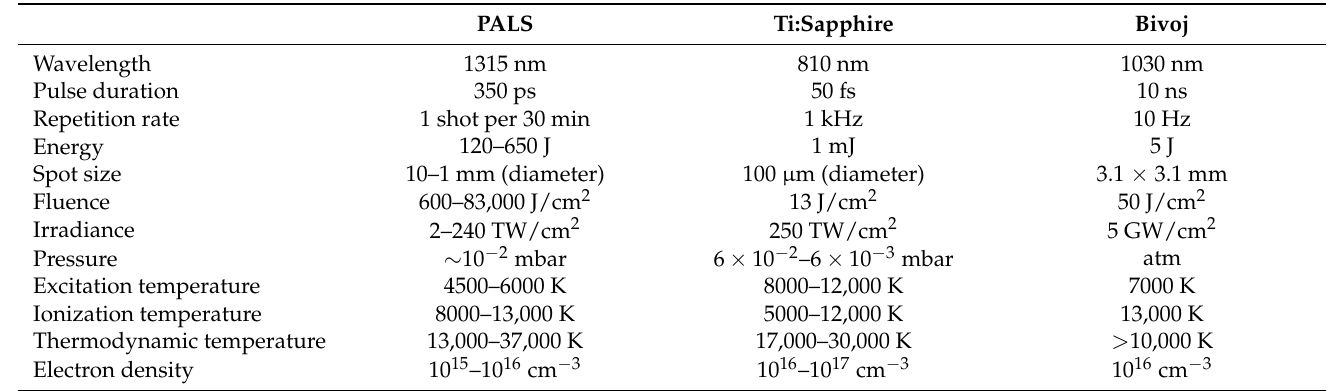
Table 2. Set experimental parameters and mean values of plasma temperatures and electron densities for the three lasers used in this study 1